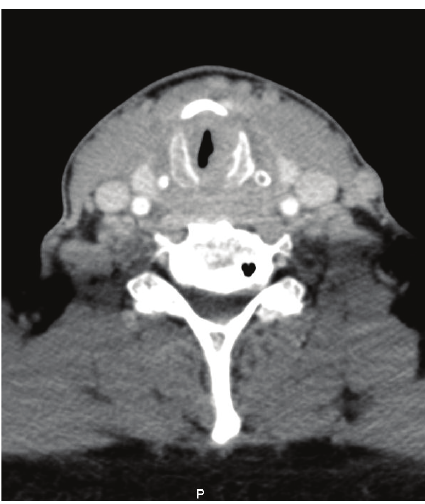
Figure 1: CT scan of the neck. Axial view showing subglottic edema and granuloma tissue on the left posterior commissure.